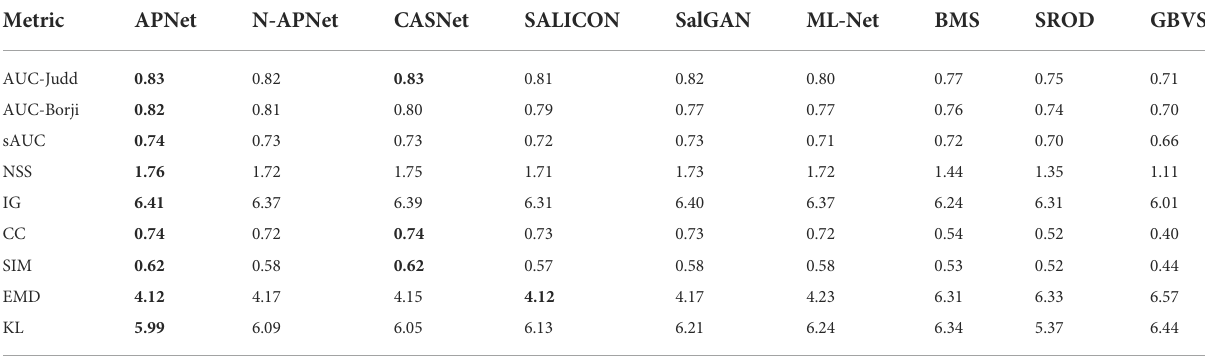
TABLE 3 Quantitative results on CGed dataset (color images). The best performance in each metric is highlighted in bold. For all evaluation metrics larger values indicate performance, except smaller is better for EMD and KL. Metric